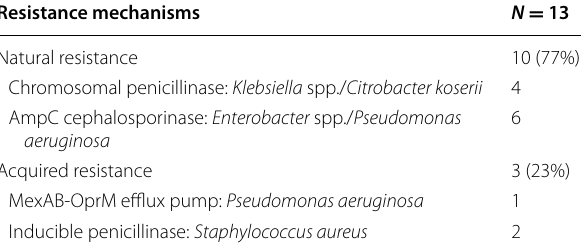
Table 4 Mechanisms of betalactamins resistance in strains